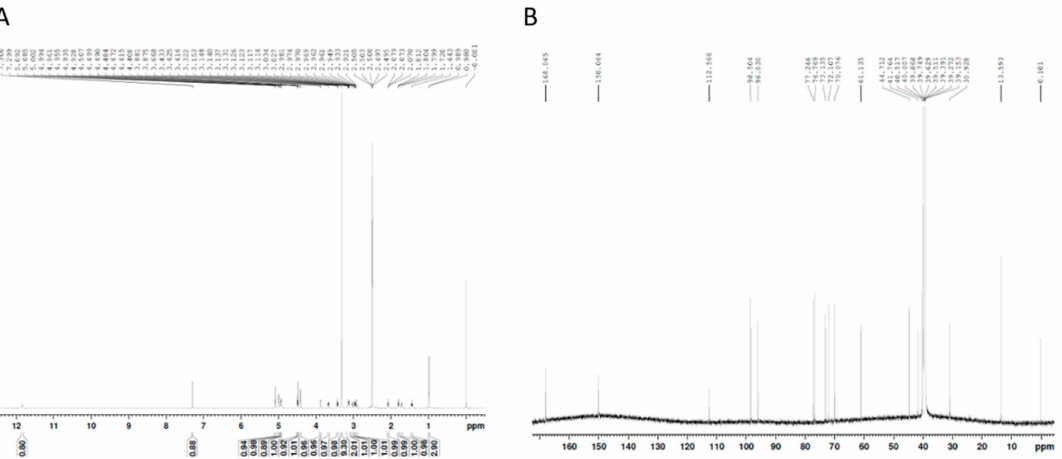
Figure 2. ( A ) Proton nuclear magnetic resonance ( 1 H-NMR), ( B ) Carbon-13 nuclear magnetic resonance ( 13 C-NMR) analysis of GL-B-03 fraction.